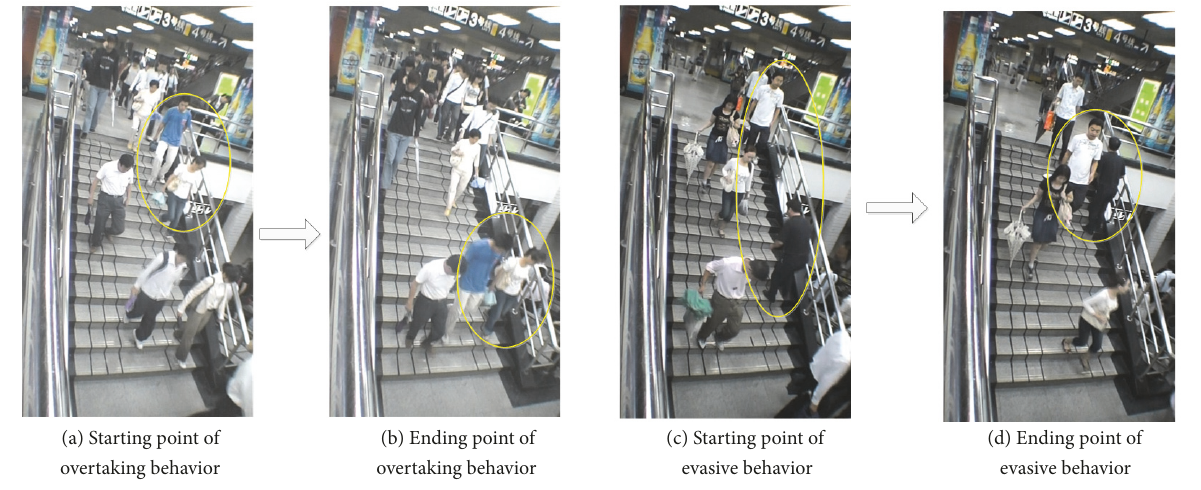
Figure 5: Illustration of the starting point and ending point of PIBs.